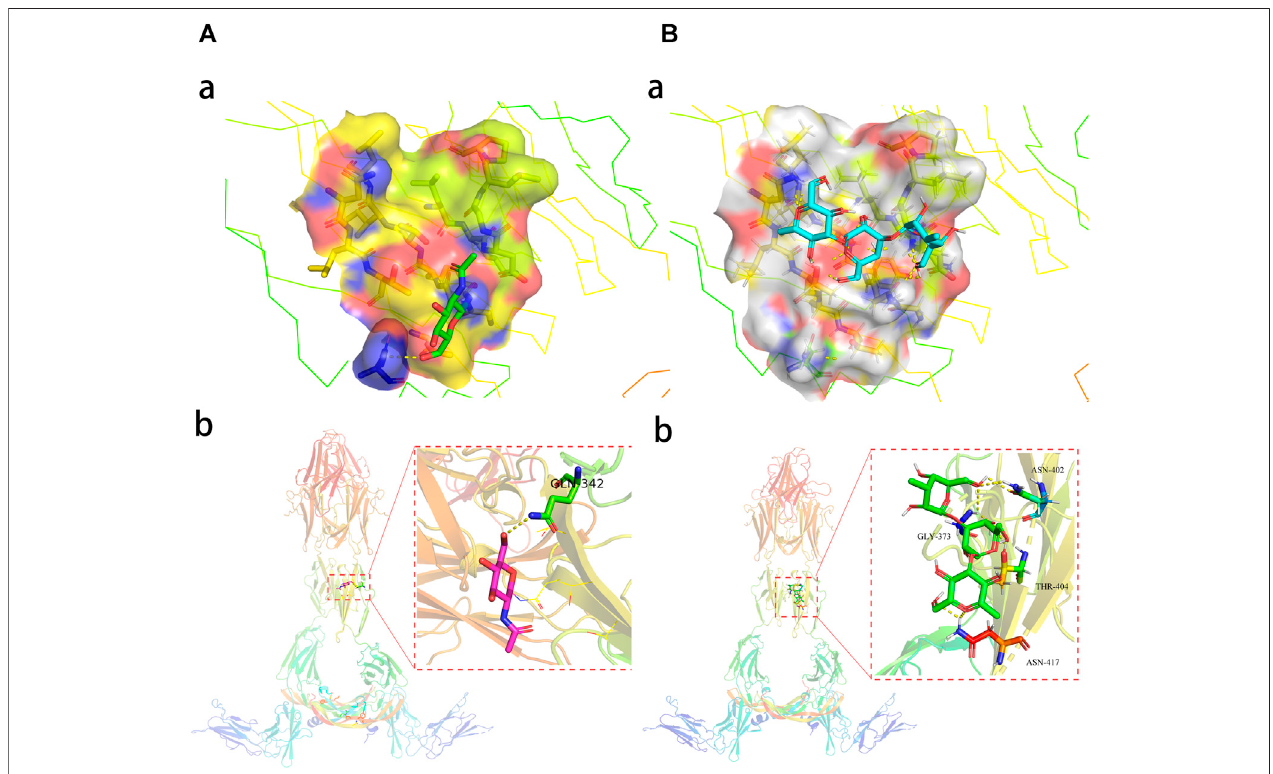
FIGURE 7 | The molecular docking data – suggested potent binding activities of Pachyman with 5T89 in VEGFA as a crucial target in HCC.